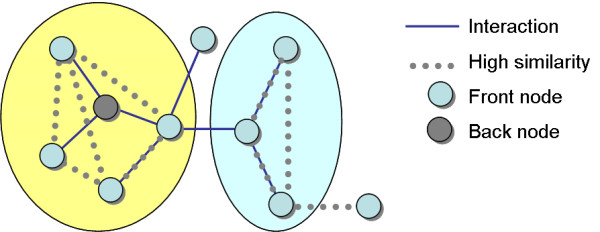
Toy input example. A toy example of an input problem with two distinct JACSs and with front and back nodes. Both JACSs (circled) are connected in the interaction network and heavy in the similarity graph. Note that the four front nodes in the left JACS form a connected subgraph only after the addition of the back node.